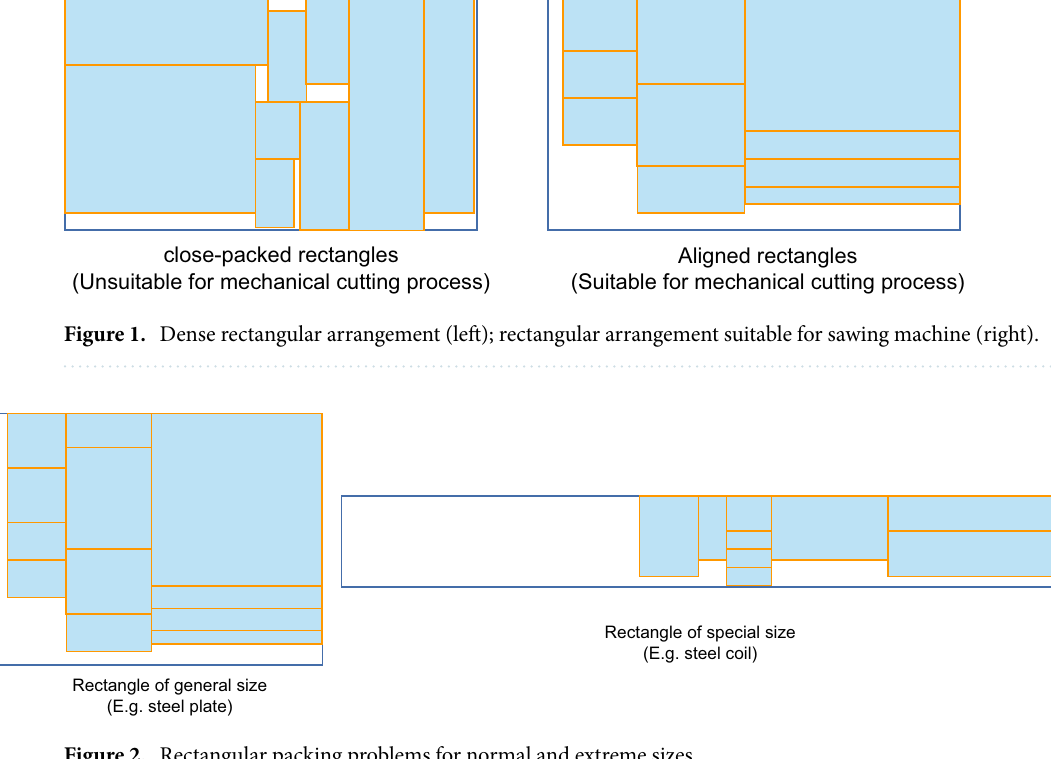
Figure 2. Rectangular packing problems for normal and extreme